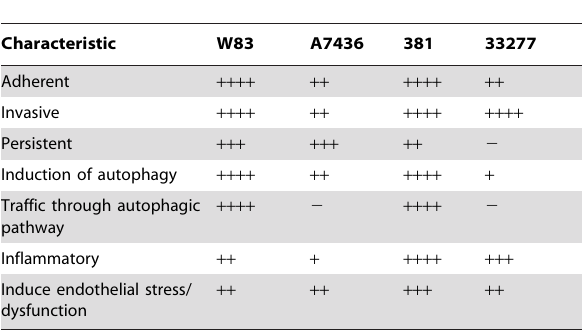
Table 2. Summary of P. gingivalis strain specific effects on HCAE